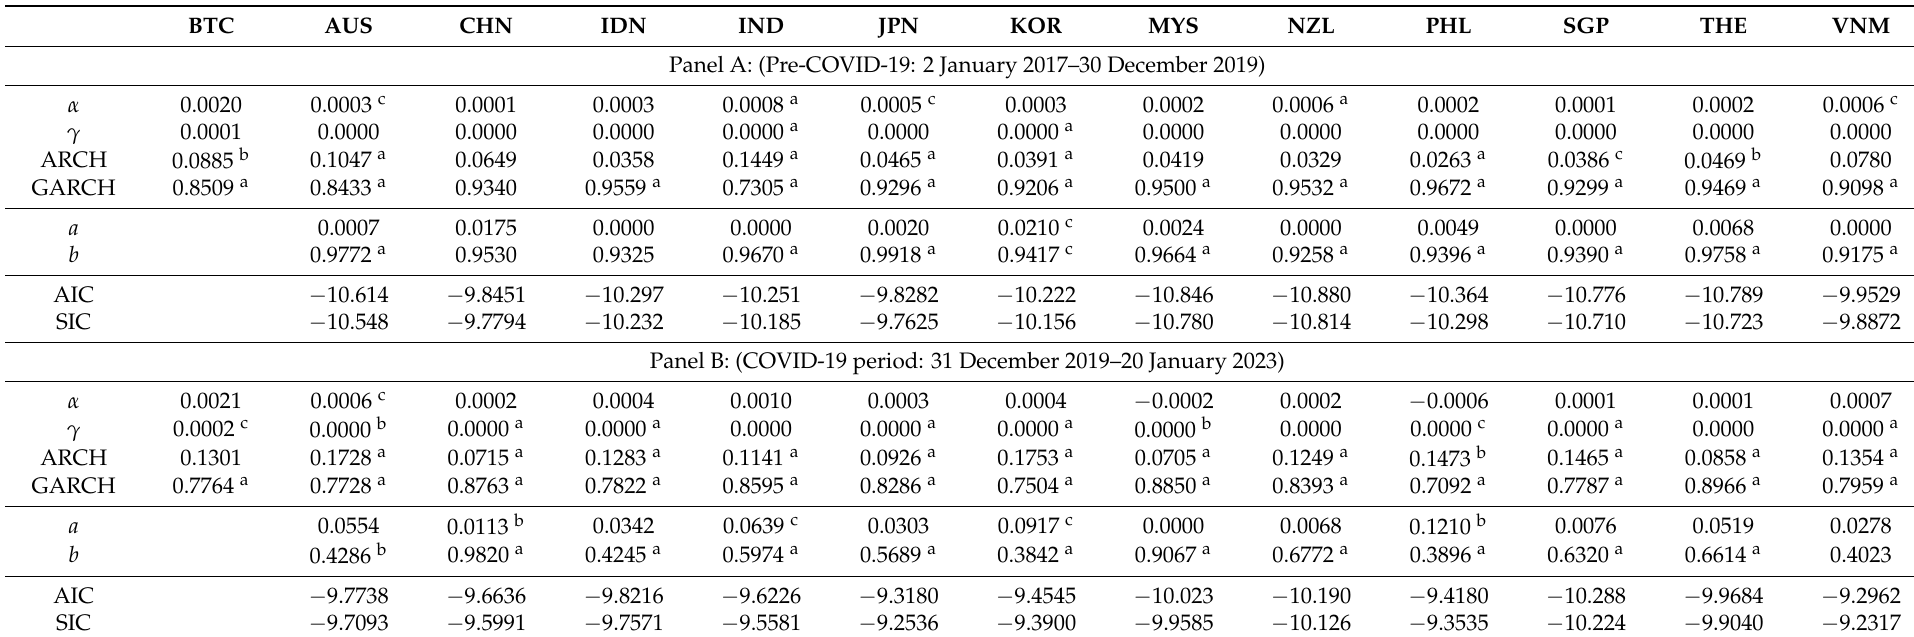
Table 2. DCC–GARCH estimated results between Bitcoin and ASEAN+6 stock